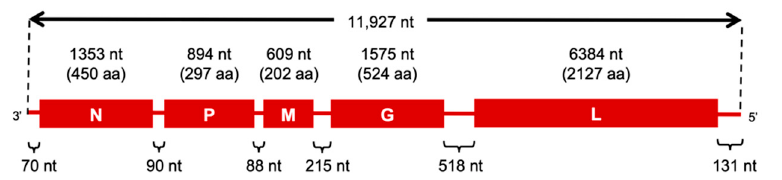
Figure 1. Schematic diagram of the genome organization of the Koma strain. Boxes and lines show open reading frames and non-coding regions, respectively. nt: nucleotides, aa: amino acids.